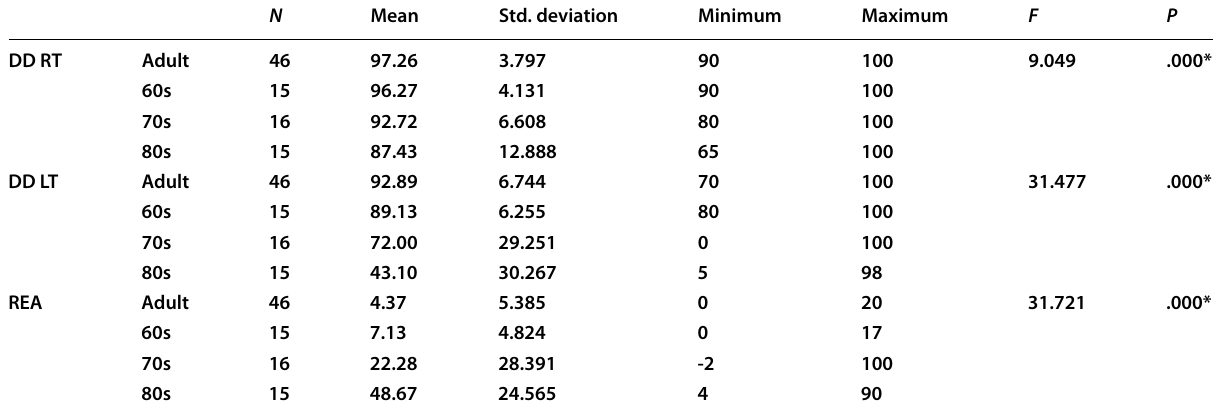
Table 6 Mean, SD, and range of the dichotic digits test (version II) (right ear, left ear, and REA) in the elderly subgroups (60s, 70s, 80s) and the adult group N Mean Std. deviation